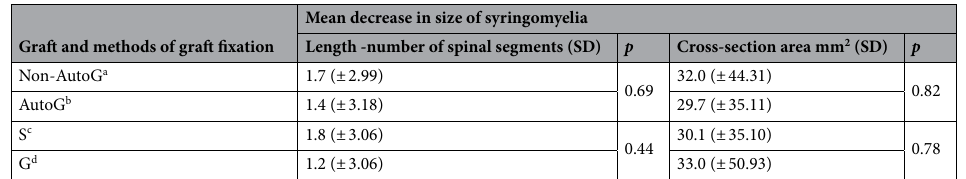
Table 4. Evolving syringomyelia on follow-up MRI depends on the kind of grafts and methods of graft fixation. 1 Non-autologous graft, 2 Autologous graft, 3 Graft fixed with sutures, 4 Graft fixed with glue.